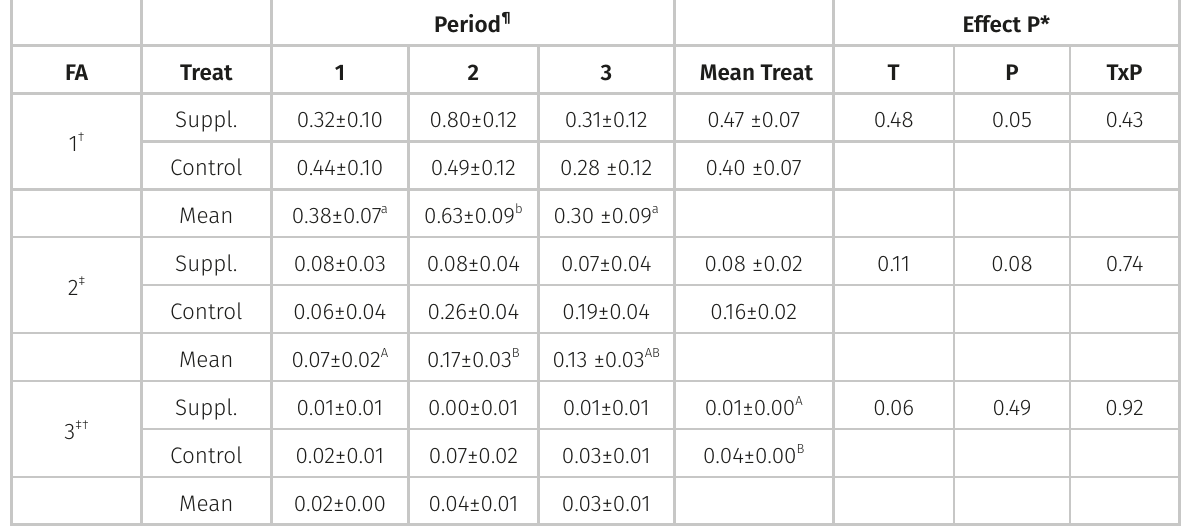
Table IV. Effect of linseed-based vegetable with addition of salmon oil Canada supplementation on the follicular fluid concentrations of polyunsaturated Omega 3 fatty acid (%) in Mangalarga Marchador